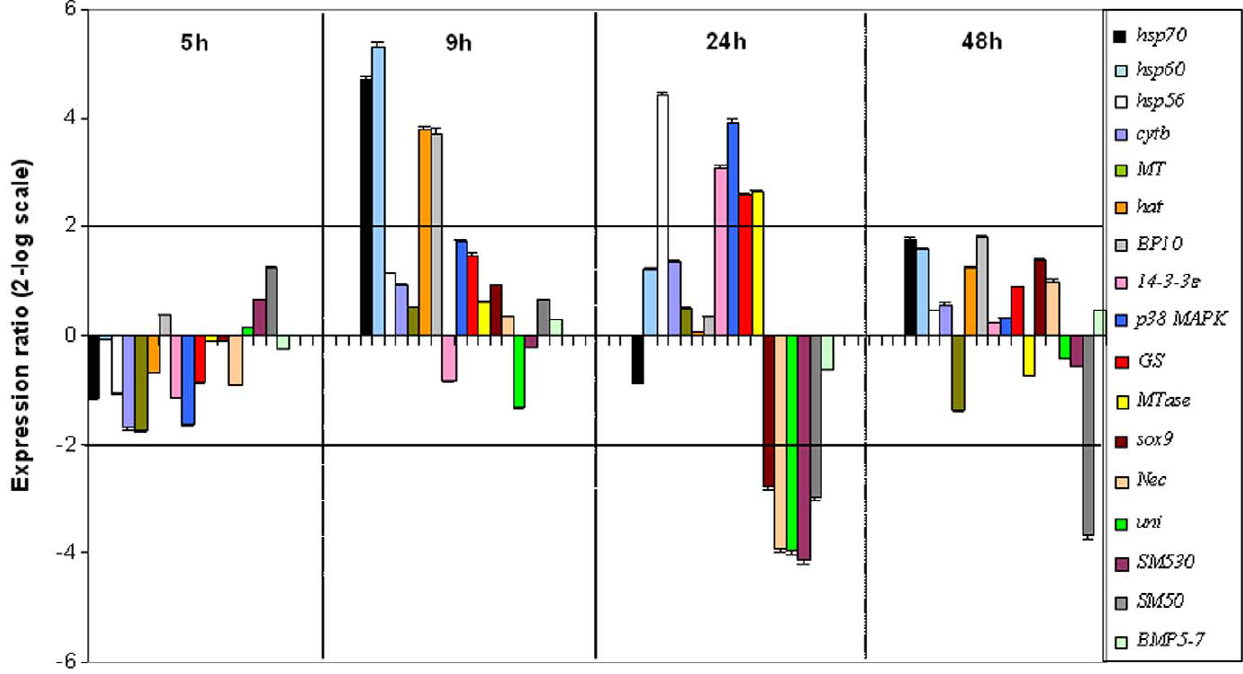
Figure 1. Gene activation in response to a low concentrations of decadienal. Histogram shows the differences in expression levels of analyzed stress genes, followed by Real Time qPCR. Embryos incubated with decadienal 0.25 m g/ml were collected at 5, 9, 24 and 48 hpf. Data are reported as a fold difference compared to control (mean 6 SD), embryos in sea water without decadienal. Fold differences greater than 6 2 (see dotted horizontal guidelines at values of 2 and 2 2) were considered significant. (For more details on genes see also Table 1 and Table S1; see also Materials and Methods for Real Time qPCR).